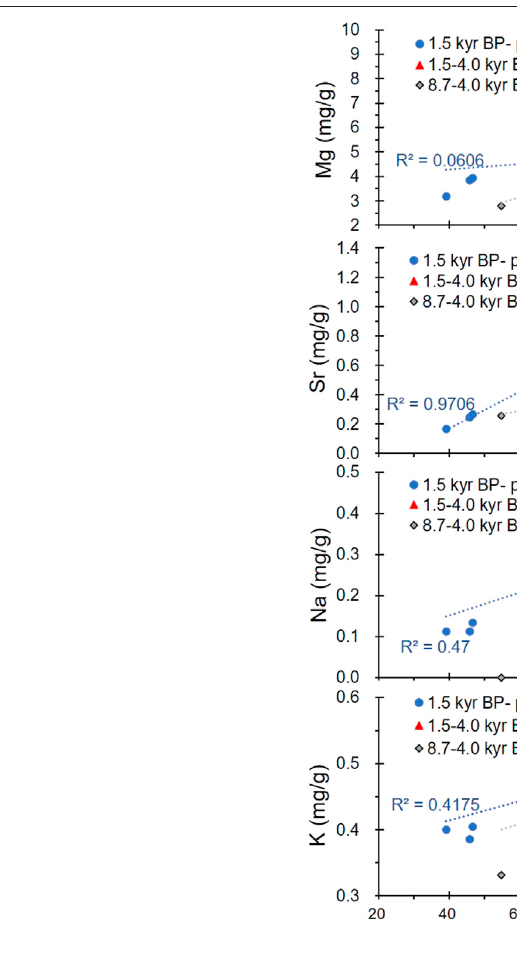
Frontiers in Earth Science |